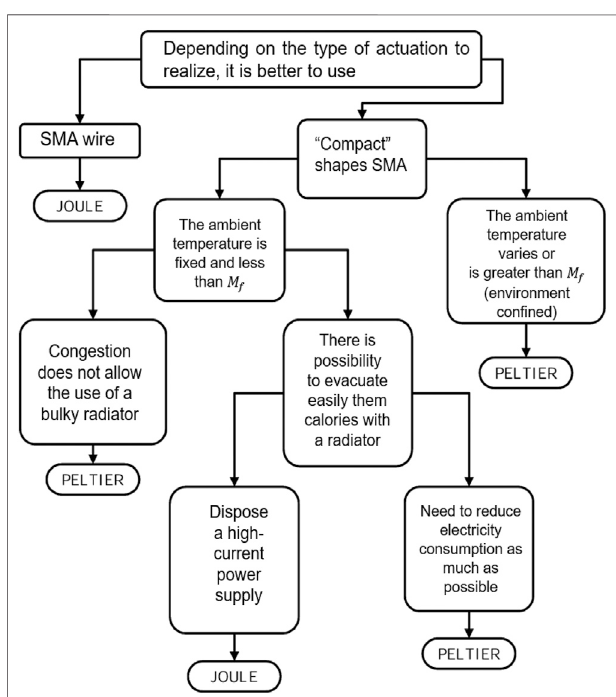
FIGURE 12 | A guideline for determination of activation method of SMA elementary actuator between Joule effect and Peltier effect (Abadie,